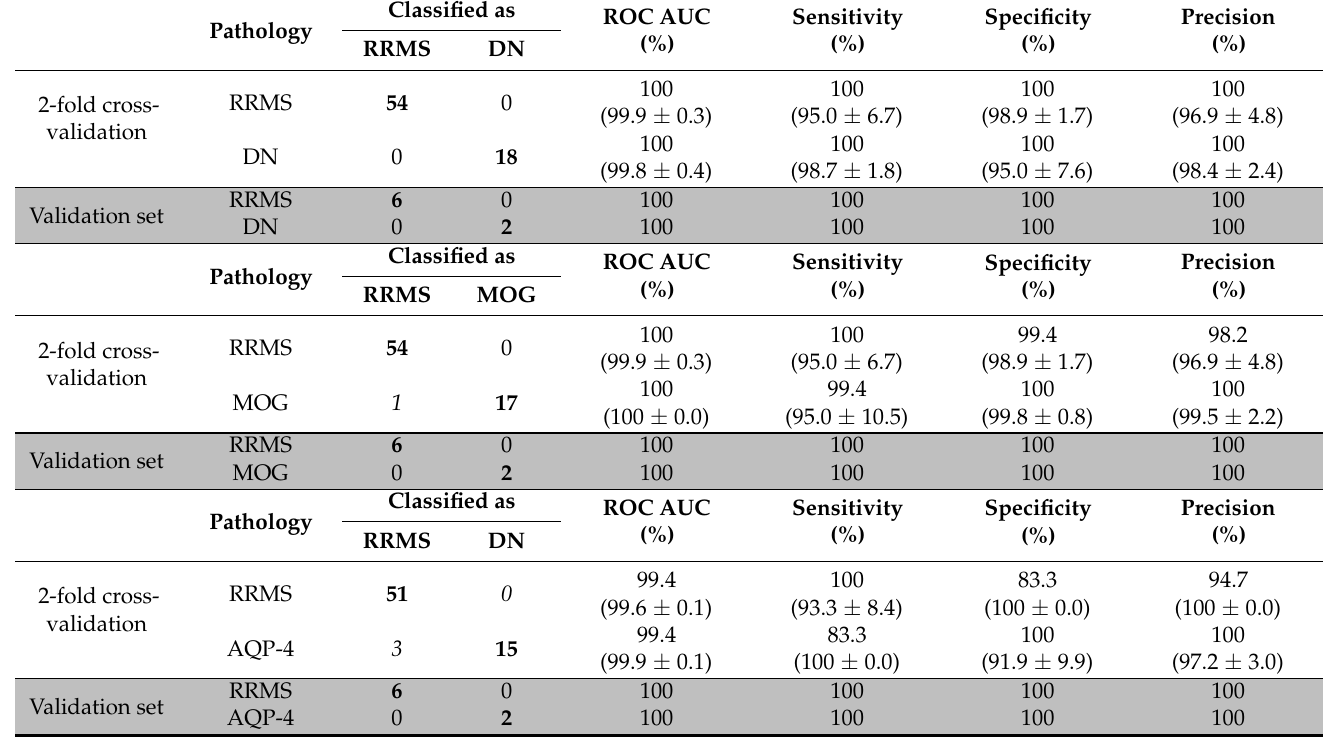
Table 3. Performances (confusion matrix, ROC AUC, sensitivity, specificity, and precision) of random forest model based on second derivatives of the FTIR spectra of the RRMS serum samples vs. DN NMOSD alone, vs. MOG NMOSD alone and vs. AQP-4 alone. The first row concerns two-fold cross-validation on the training set (18 DN, 18 AQP-4 and 18 MOG). The values in parentheses correspond to a ten-iteration internal validation of the model (see Materials and Methods for details). The grey rows record the performances on the test set (6 RRMS, 2 DN, 2 MOG and 2 AQP-4). True positives are in bold and false negatives/false positives are in